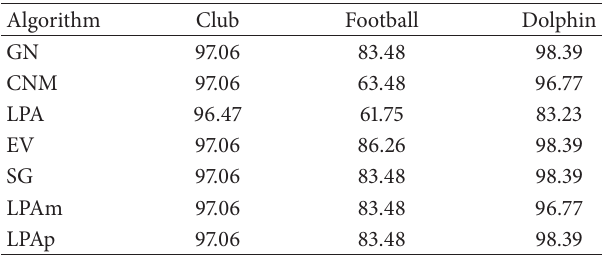
Table 6: Comparison between FVCC (%) by different algorithms on three real-world networks.